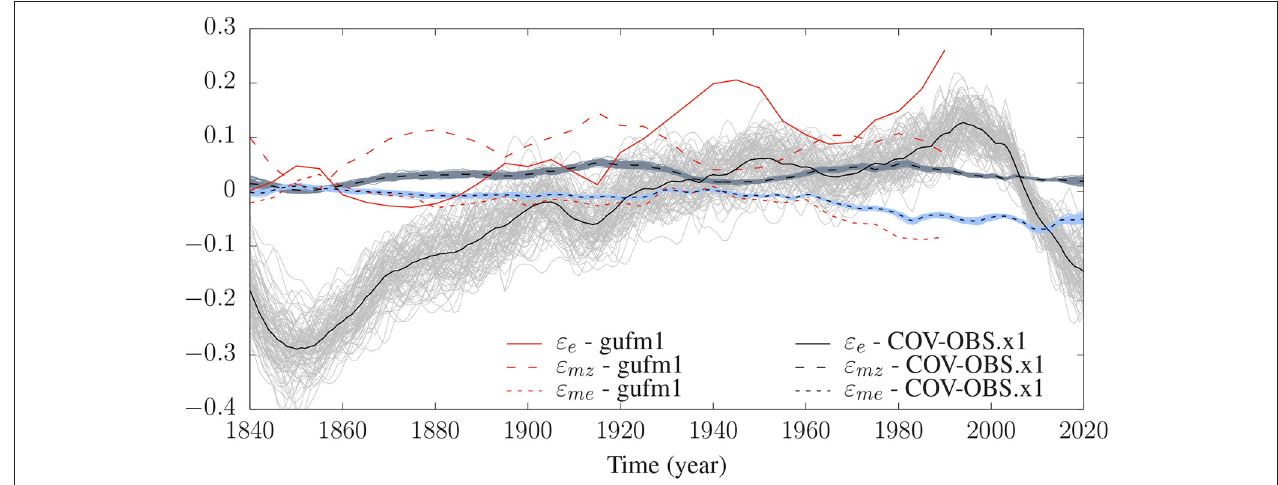
FIGURE 6 | Evolution of the ratios ε e (solid lines), ε mz (dashed lines), and ε me (dotted lines) using gufm1 (red lines) and the mean of COV-OBS.x1 (dark lines). The family of 100 COV-OBS.x1 models is presented in light, dark gray, and light blue solid lines for ε e , ε mz , and ε me ,